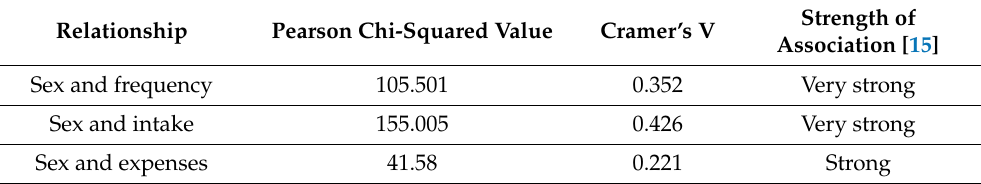
Table 7. Test of association for